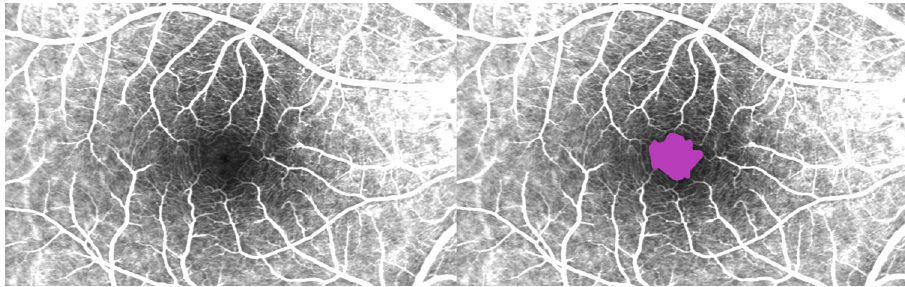
Fig 1. Optimized fluorescein angiography image. Brightness and image contrast optimization in an early phase fluorescein angiography image (Field 2) without and with annotated FAZ area (magenta).